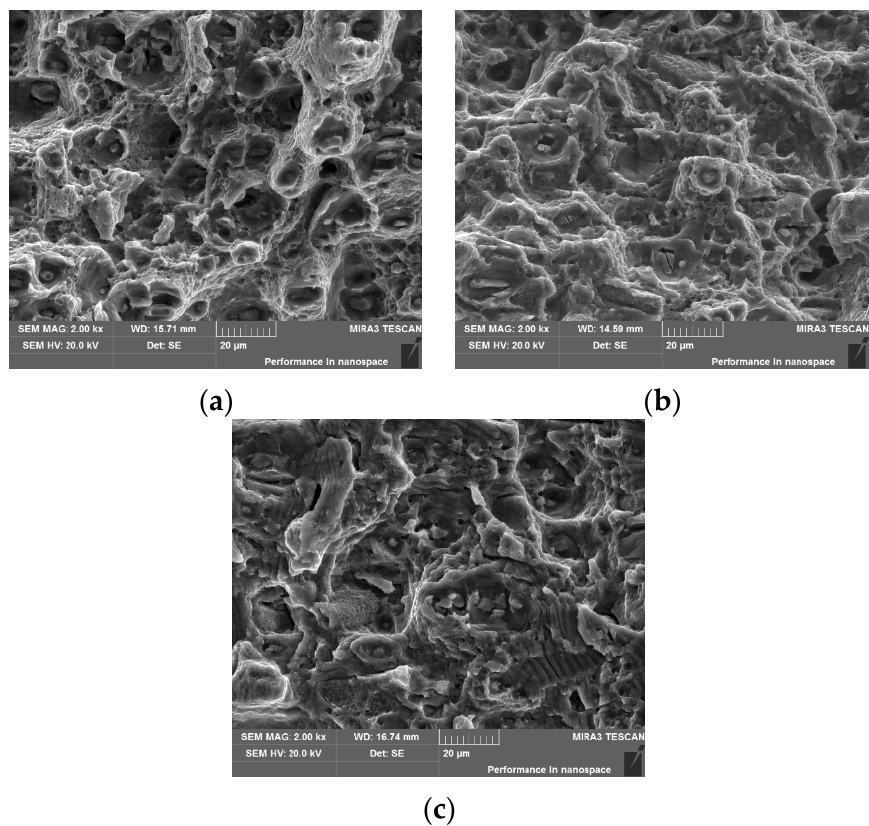
Figure 5. Instant fracture area: ( a ) T3; ( b ) AA; ( c )